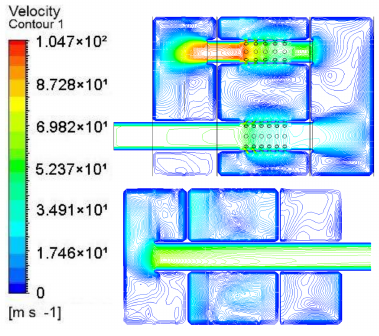
Figure 10. Contour of velocity in the cross section of the silencer.